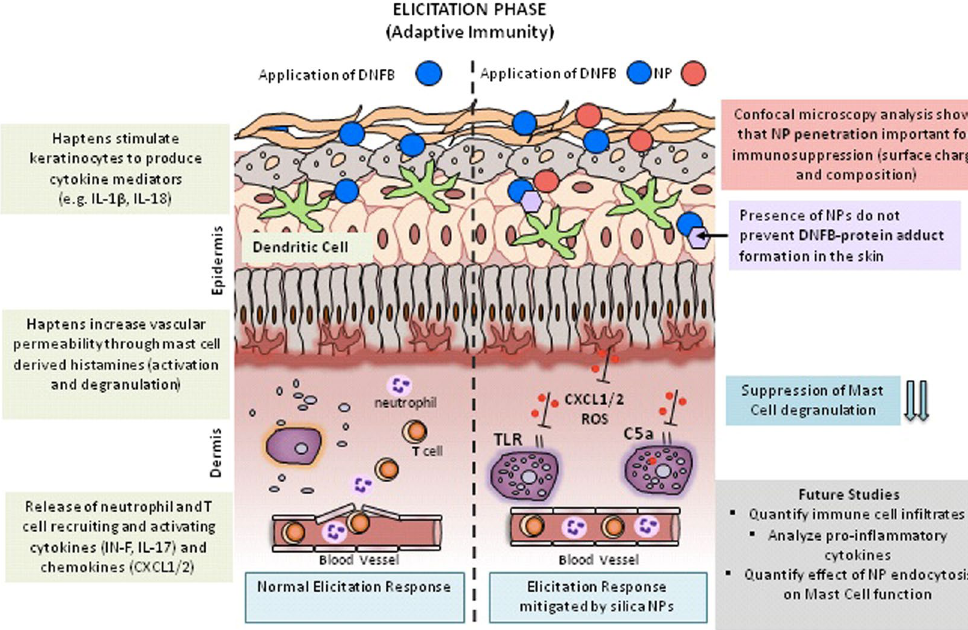
Figure 9. Schematic summary of findings, future directions and postulated mechanisms of action of NPs in the elicitation phase (adaptive and innate immunity). The illustration contrasts the difference between a normal elicitation response and how negatively charged NPs < 200 nm may possibly modulate the immune responses when co-challenged with a T H 1 sensitizer like DNFB. In a normal elicitation response the sensitizer combines with skin proteins to form an immunogenic hapten that stimulates keratinocytes to produce cytokine proinflammatory mediators like ROS, IL-1 β and IL-18. These signals activate vascular endothelial cells that guide immune cells to the tissue. Early cascade of events (2–4 hours) involves mast cell degranulation, histamine release and secretion of neutrophil recruiting chemokines like CXCL1 and CXCL2. Between 12–24 hours of elicitation, antigen-specific memory T cells are recruited to the tissue and are activated by local antigen carrying dendritic cells. This leads to production of IFN- γ and IL-17, which further activates tissue resident T cells and causes a full blown allergic response. Our results indicate that NP charge, composition and presence in the tissue modulates the ear swelling response in mice by possibly mitigating early immune events including mast cell degranulation and subsequent recruitment of other immune cells. NPs may modulate epidermal derived signals that inhibit complement or TLR receptor signaling. NPs may also be endocytosed by mast cells that can affect their